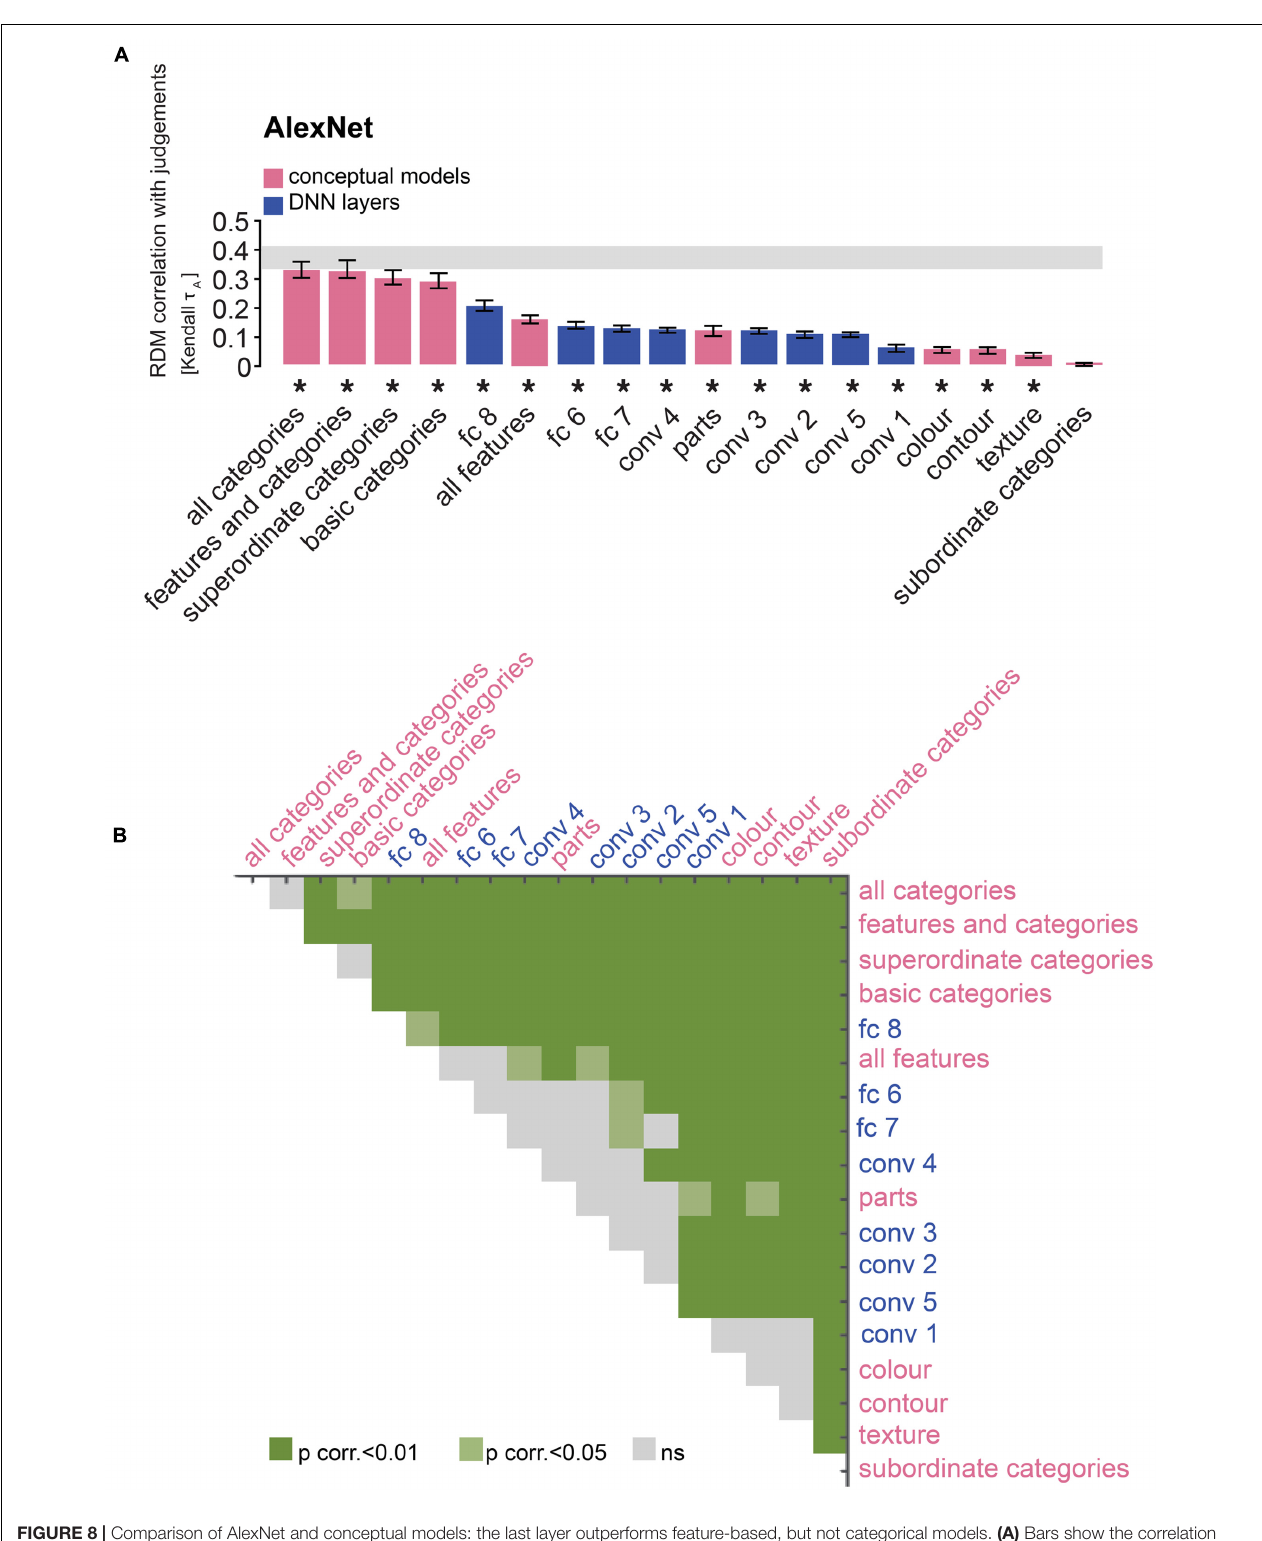
Frontiers in Psychology |